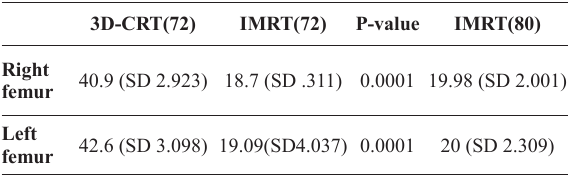
Table 5: Mean dose to both